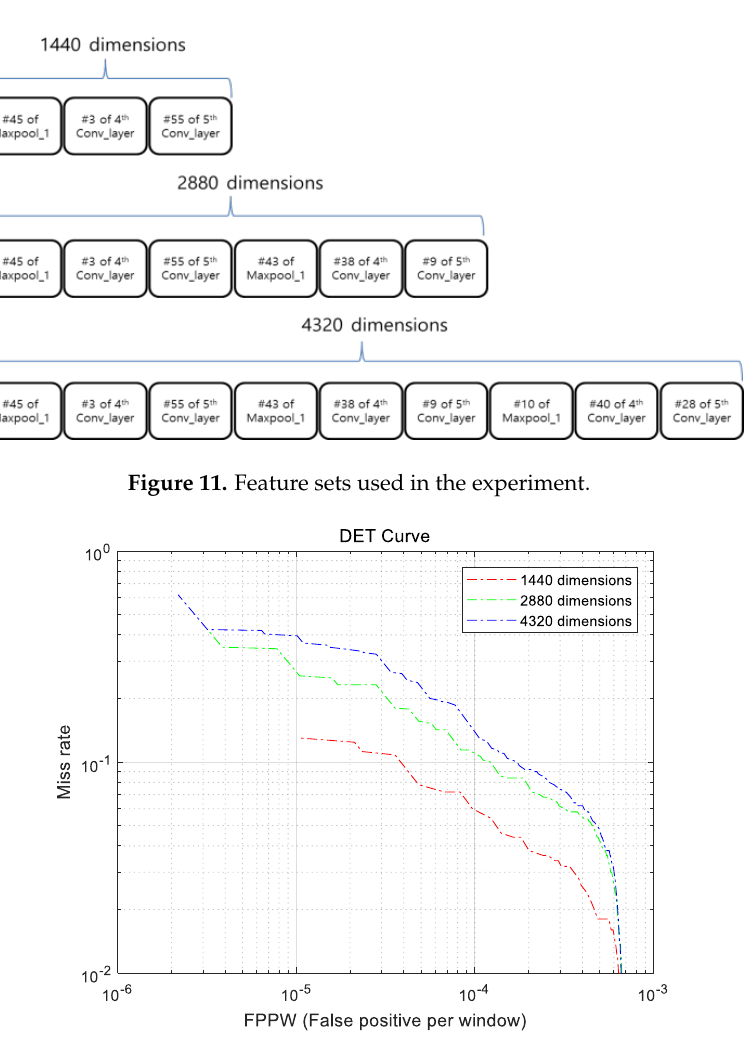
( c ) Figure 10. Top-three activation feature maps selected: ( a ) Maxpool_1 layer, ( b ) fourth convolution layer, and ( c ) fifth convolution layer. 3.3. Experiment 1 The first experiment compared the performance depending on the feature combination dimension, using the feature sets shown in Figure 11. Feature set 1 concatenated the first maximum feature map from each layer sequentially (the Maxpoo1, fourth convolution, and fifth convolution layers). Feature set 2 concatenated the first and the second maximum feature maps sequentially, and